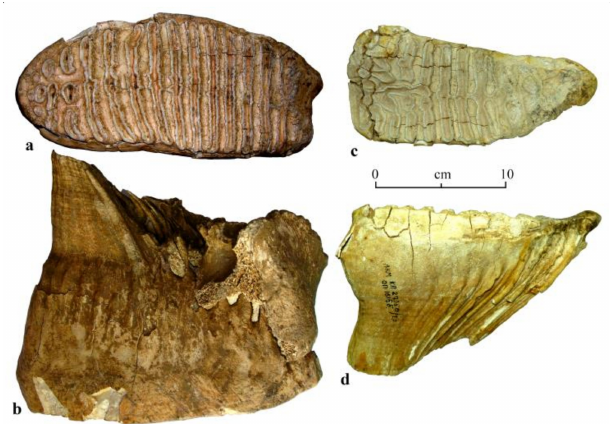
Figure 5. Tooth of mammoth Mammuthus intermedius from Beglitsa (Rostov Region, Russia; the late Middle Pleistocene): ( a , b )—private collection, right M3, lingual view, occlusal surface. Peschanokopskoe. An isolated upper heavily worn left M3; collection of ROMK. A fragment of a mandible with a heavily worn right m3; collection of ROMK. A lower left heavily worn m3 with a fragment of a mandible; collection of AMZ. All finds belong to one individual (Figure 6). The color of the dentine is light-creamy, and the color of the enamel is white.